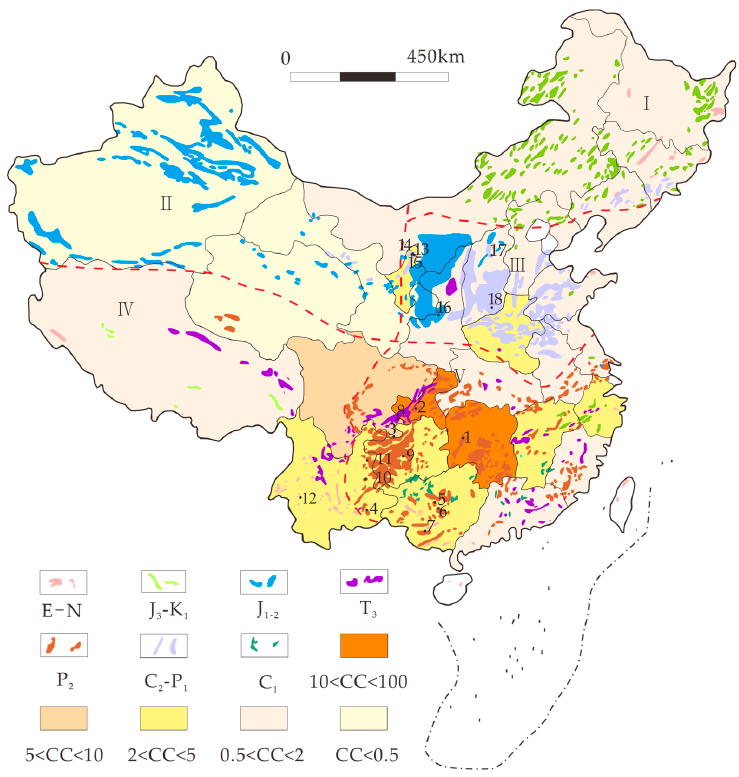
Figure 2. Distribution of cadmium in Chinese coals, modified from Dai et al. [7]. I. Northeastern area; II. Northwestern area; III. Northern area; IV. Tibet–Western Yunnan area; V. Southern area; CC: concentration coefficient, cadmium value from Dai et al. (0.25 μ g/g) [7] was used to determine CCs; 1. Chenxi; 2. Moxinpo; 3. Shiping; 4. Yanshan; 5. Yishan; 6. Heshan; 7. Fusui; 8. Guxu; 9. Zhijin; 10. Laochang; 11. Xuanwei; 12. Lincang; 13. Shizuishan; 14. Baijigou; 15. Rujigou; 16. Chenjiashan; 17. Fanci; and 18. Yuanqu. Reproduced with permission from Dai et al; Published by Elsevier, 2012.